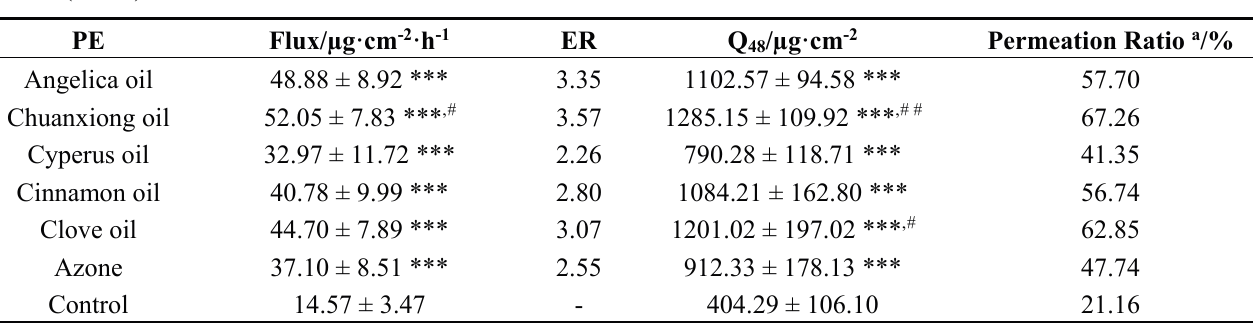
Table 6. Effect of PEs on the percutaneous permeation parameters of ibuprofen through excised rat skin (n =